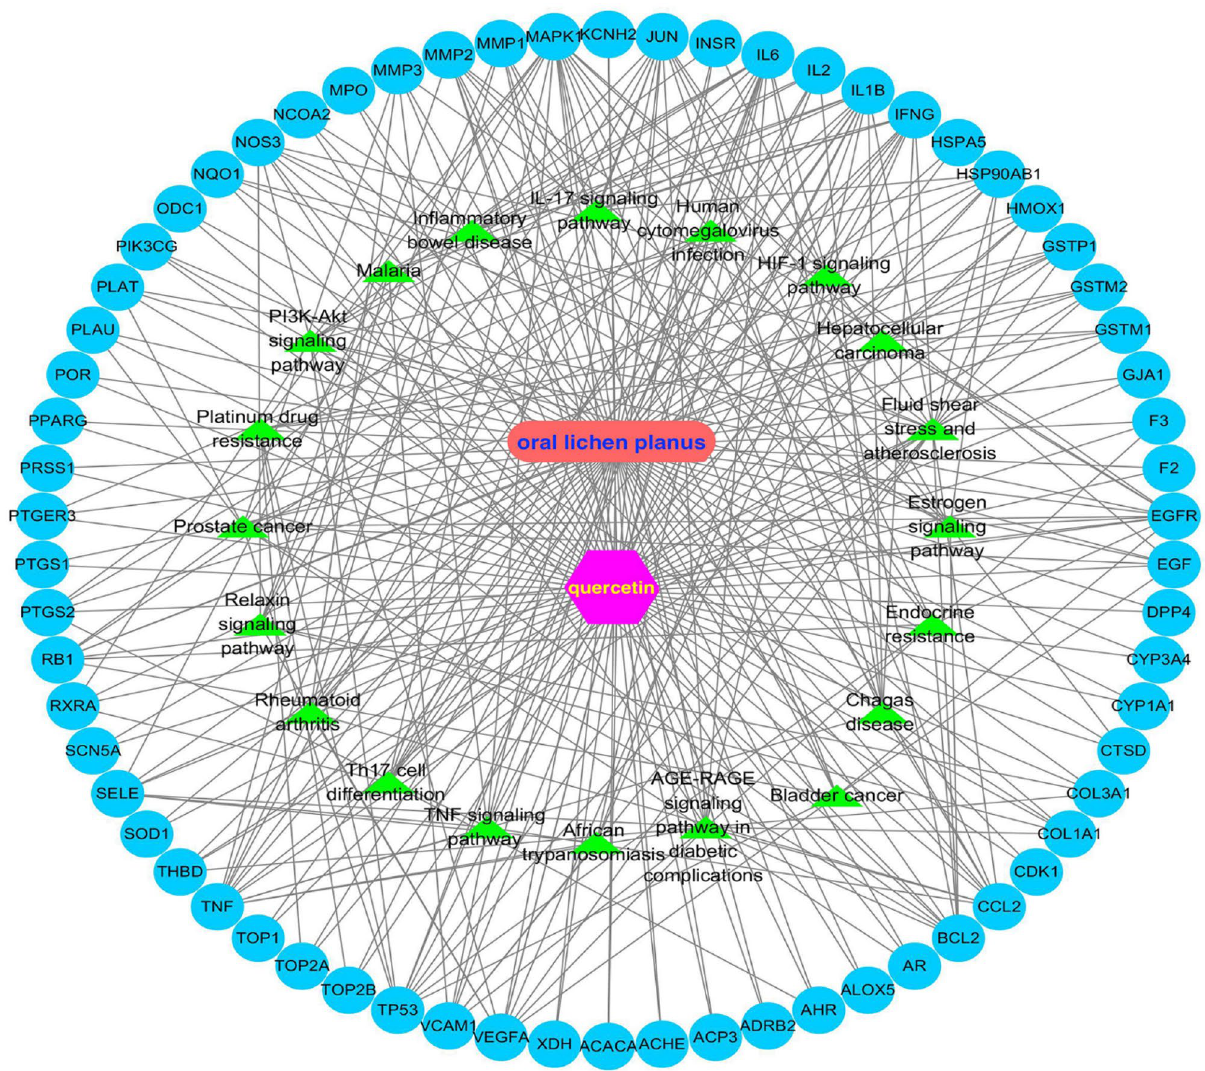
Figure 6. The drug–disease–pathway–target interaction network was drawn by Cytoscape software. The green color indicated the top 20 pathways; the blue circles represented the common targets of quercetin and